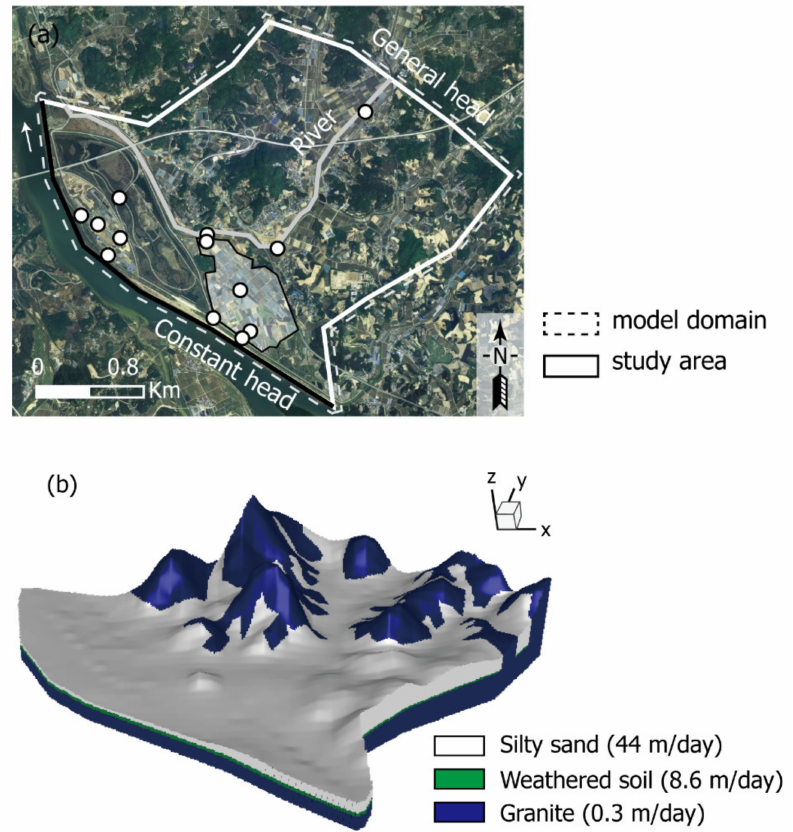
Figure 3. ( a ) Conceptual model showing boundary conditions and locations of 13 monitoring wells (circles) with the study area near the river (polygon) and ( b ) spatial distribution of hydraulic